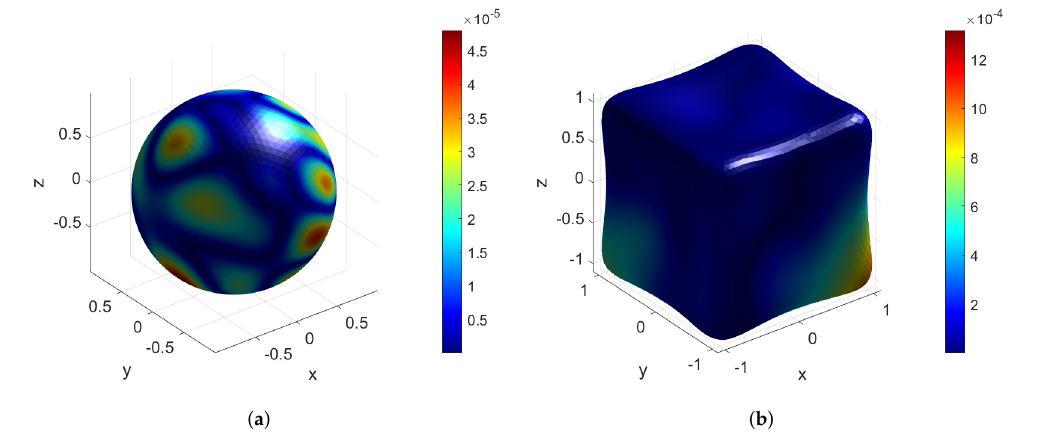
Figure 8. Example 3: Snapshots of absolute error distribution under width = 50 and depth = 4 for nonlinear problems on ( a ) a unit sphere and ( b ) tooth